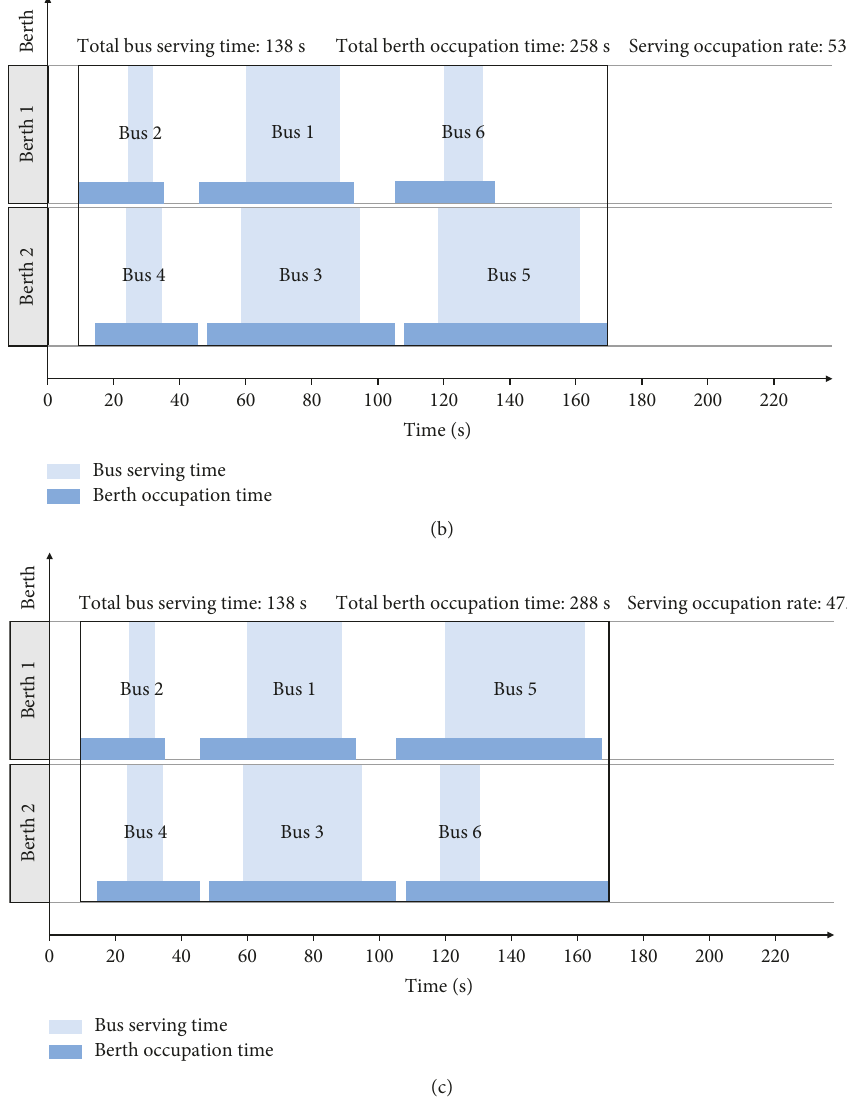
Figure 7: Berth-time occupation diagrams of scenario 3: (a) M0 , (b) M1 , and (c) M2